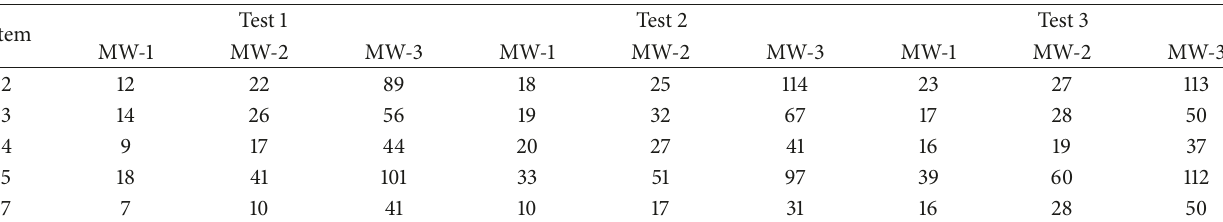
Table 4: Peak dynamic strain values during the